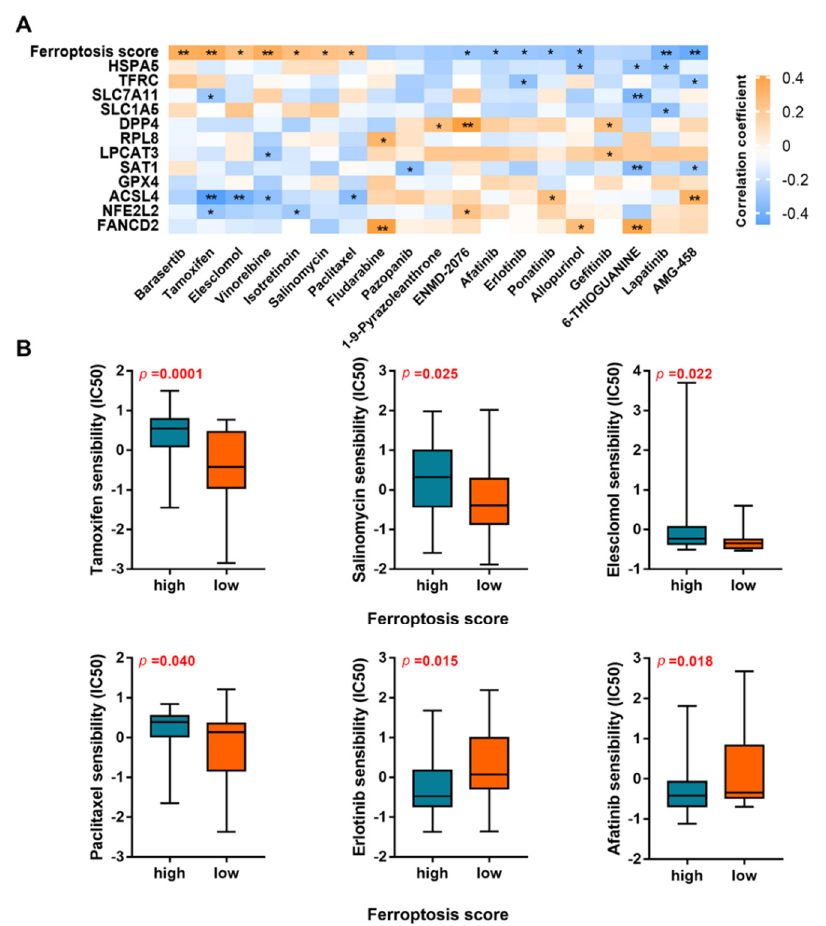
Figure 6. Identification of novel candidate compounds targeting the ferroptosis-related model. ( A ) Correlation analysis of compound activity of drugs and ferroptosis-related risk score/gene in NCI 60 cell line. ( B ) Comparation of drug sensibility between cell lines with high and low ferroptosis scores. IC50, half-maximal inhibitory concentration. *, p < 0.05; **, p < 0.01.